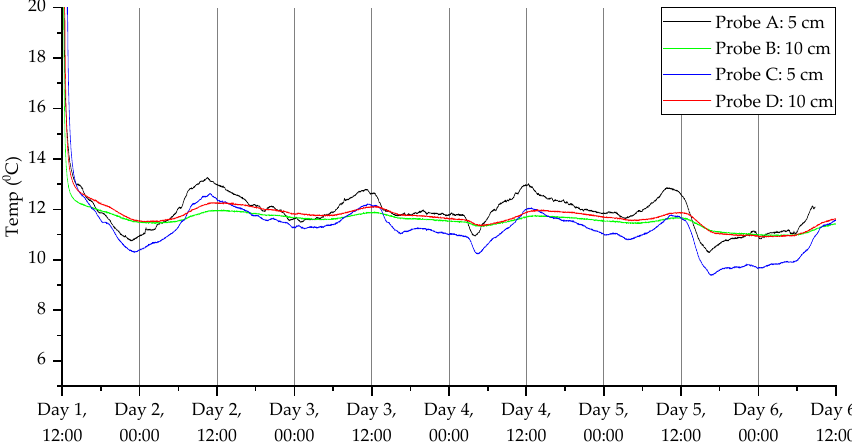
Figure 11. Temperature measurements for the deployment in Warwick campus woodland. Data collection commenced on 11 November 2021 at 12:40 (24 h time).